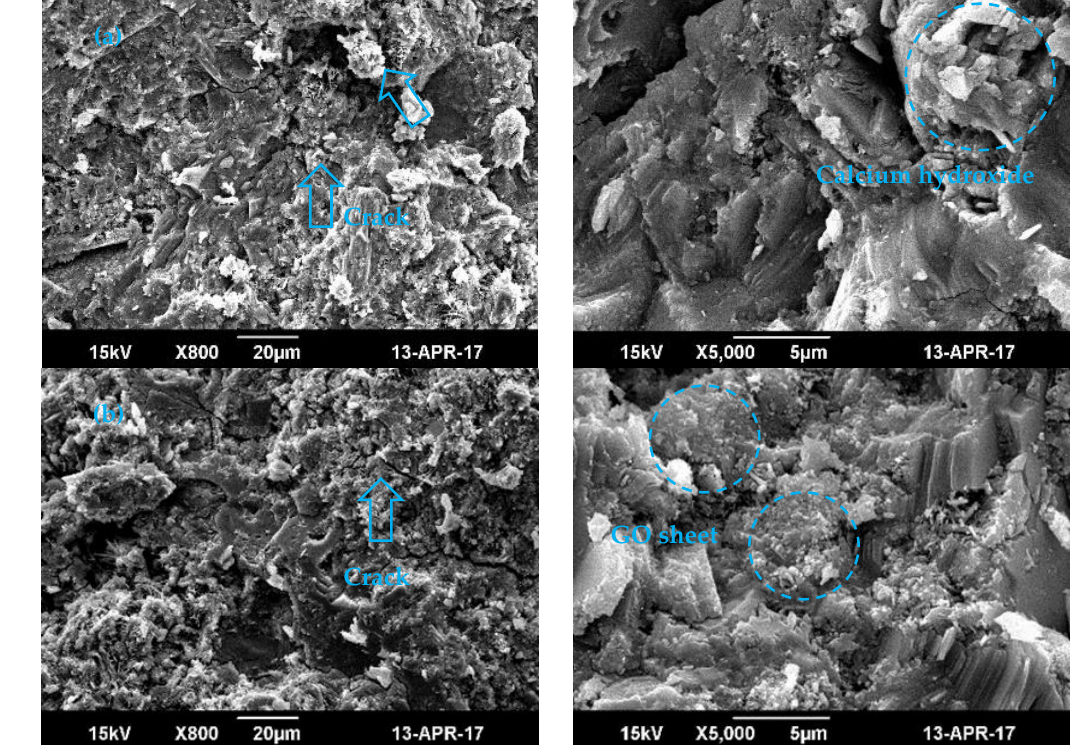
Figure 6. SEM image of the test piece [22]: ( a ) ordinary cement; ( b ) GO cement (0.06%).